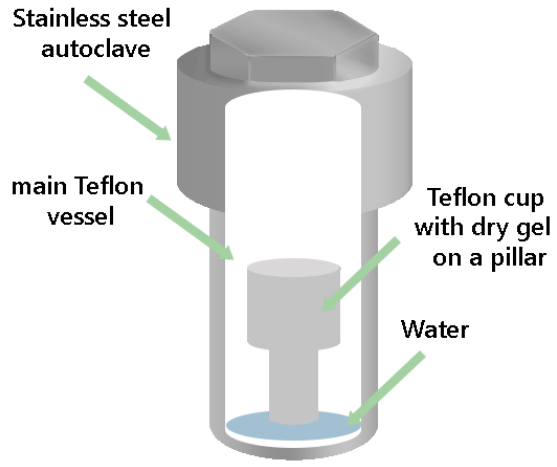
Figure 1. Scheme of a vessel for steam-assisted